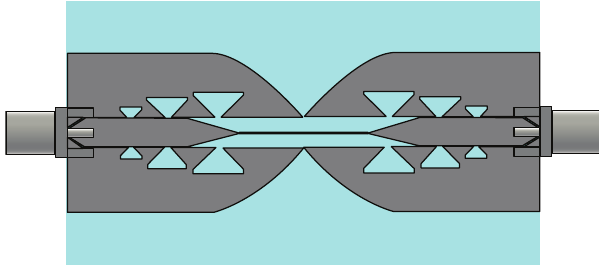
Figure 9: Back-to-back configuration of the